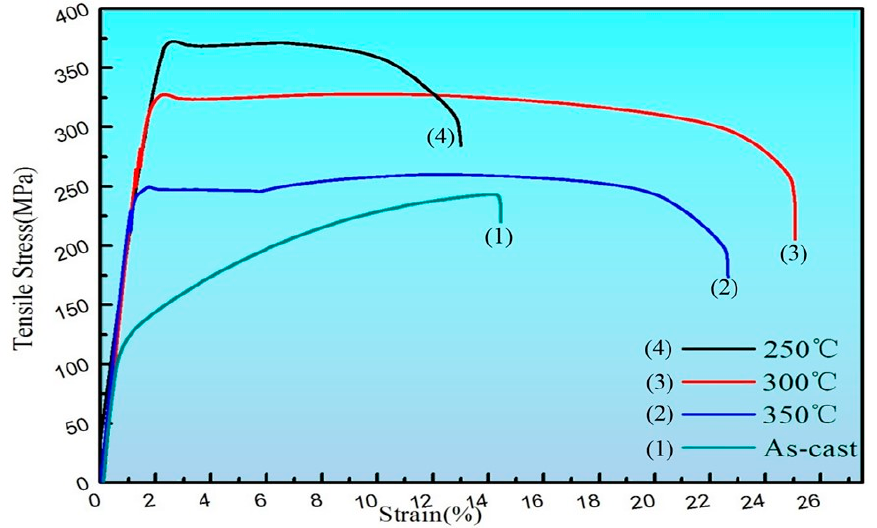
Figure 6. The tensile stress ‐ strain curves of as ‐ cast and as ‐ extruded. Table 2. Mechanical properties of alloys at different extrusion temperatures.